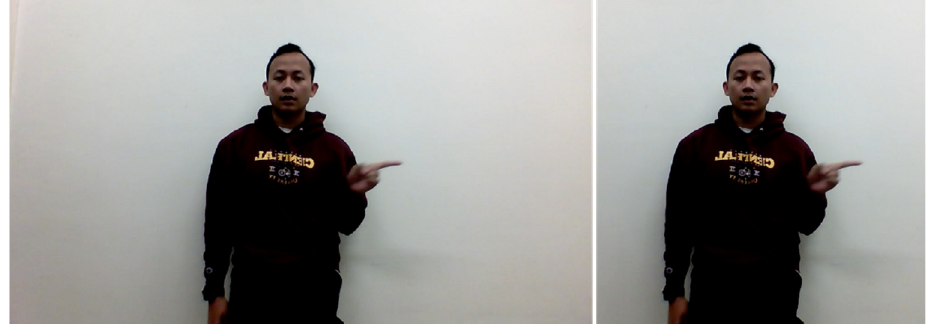
Figure 3. Full-frame feature using RGB image, the ( left image) is the original image, and the ( right image) is the cropped image to adjust with the proposed model.